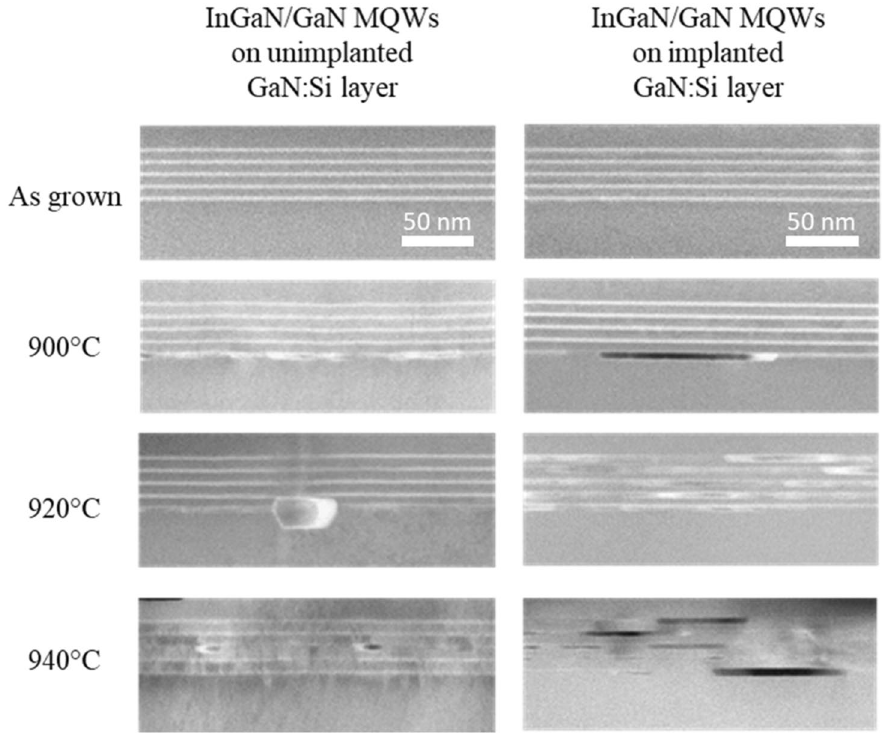
Figure 12. Set of STEM images of MQWs grown on unimplanted and implantes GaN:Si layer, as grown and after annealing at 900 °C, 920 °C and 940 °C. All images have the same